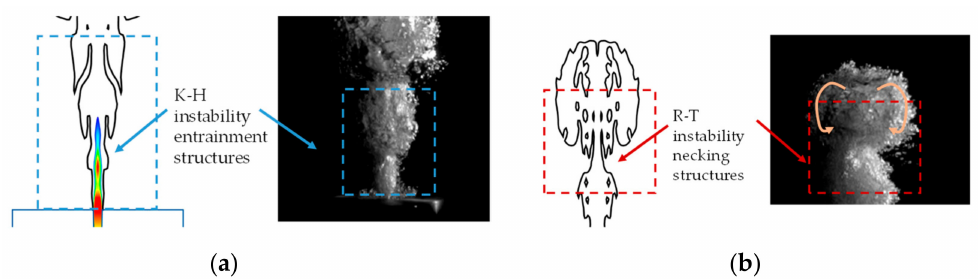
Figure 22. Discriminant coe ffi cient ( a ) 1 ms ( b ) 10 ms.